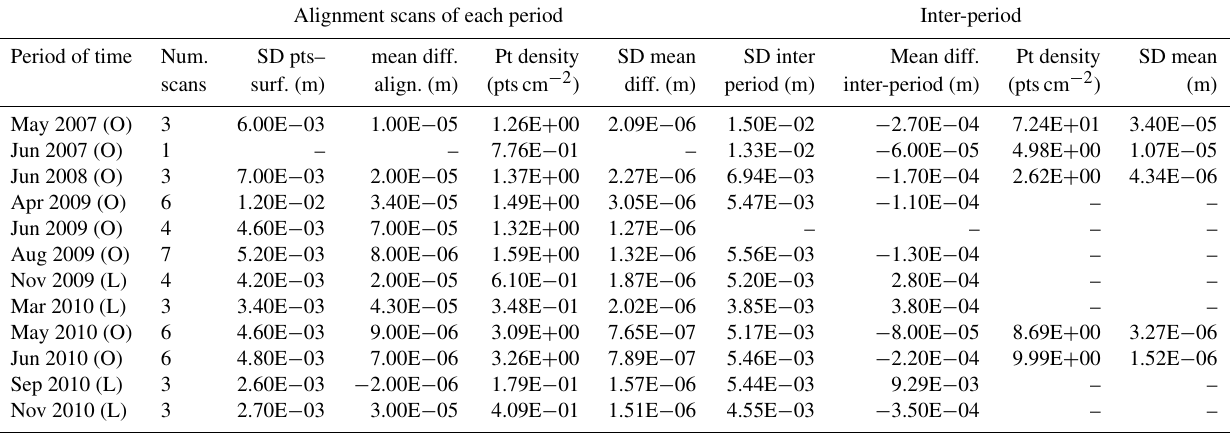
Table 1. Characteristics of the TLS alignment with, for each time period, the information on the number of scans used to create a scene. The table indicates standard deviation (SD) of the point from the surface matched (point-to-surface ICP), the mean difference between two scans (either used to align with period or for inter-period comparison), the average point density used, and the standard deviation of the average mean